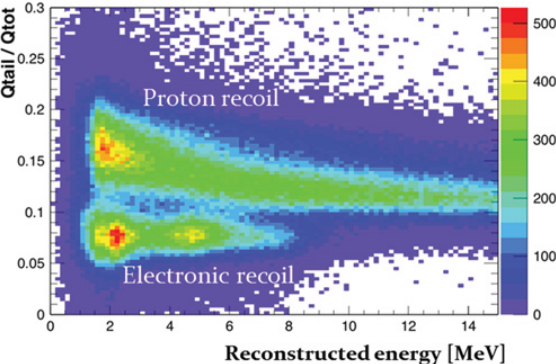
Figure 2. Distribution of the PSD value, defined as the ratio of the integrated charge in the tail of the pulse ( Q tail ) to the total charge Q tot , as a function of the reconstructed energy for the prompt signal of IBD-like events collected in cell 1 during reactor turned off period.